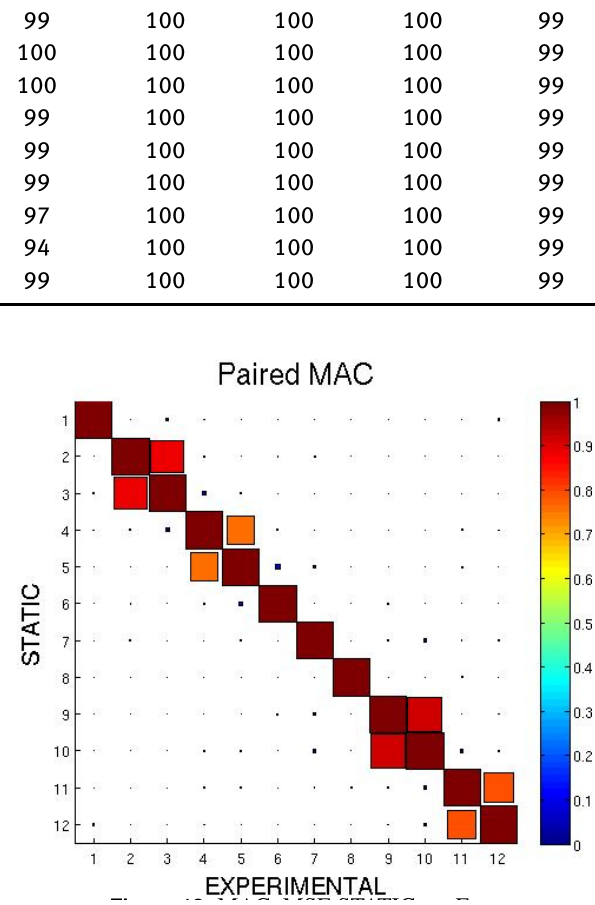
Figure 12: MAC: MSE STATIC vs. Exp.